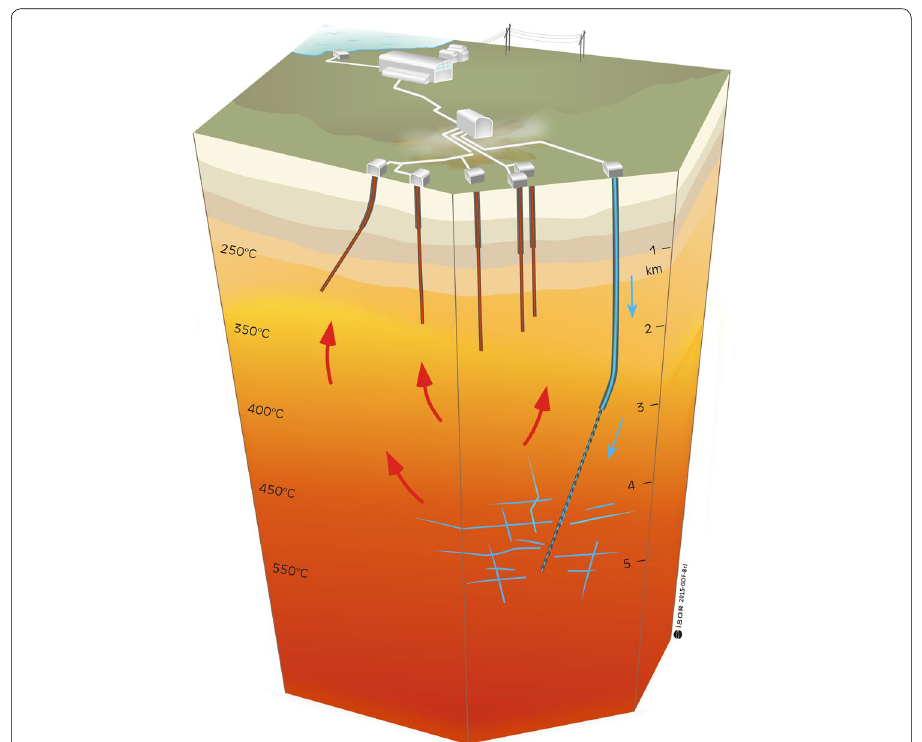
Fig. 1 Conceptual model of the Reykjanes geothermal field showing the existing conventional geothermal wells ( brown ) and the IDDP-2 well ( blue ) (Friðleifsson et al.